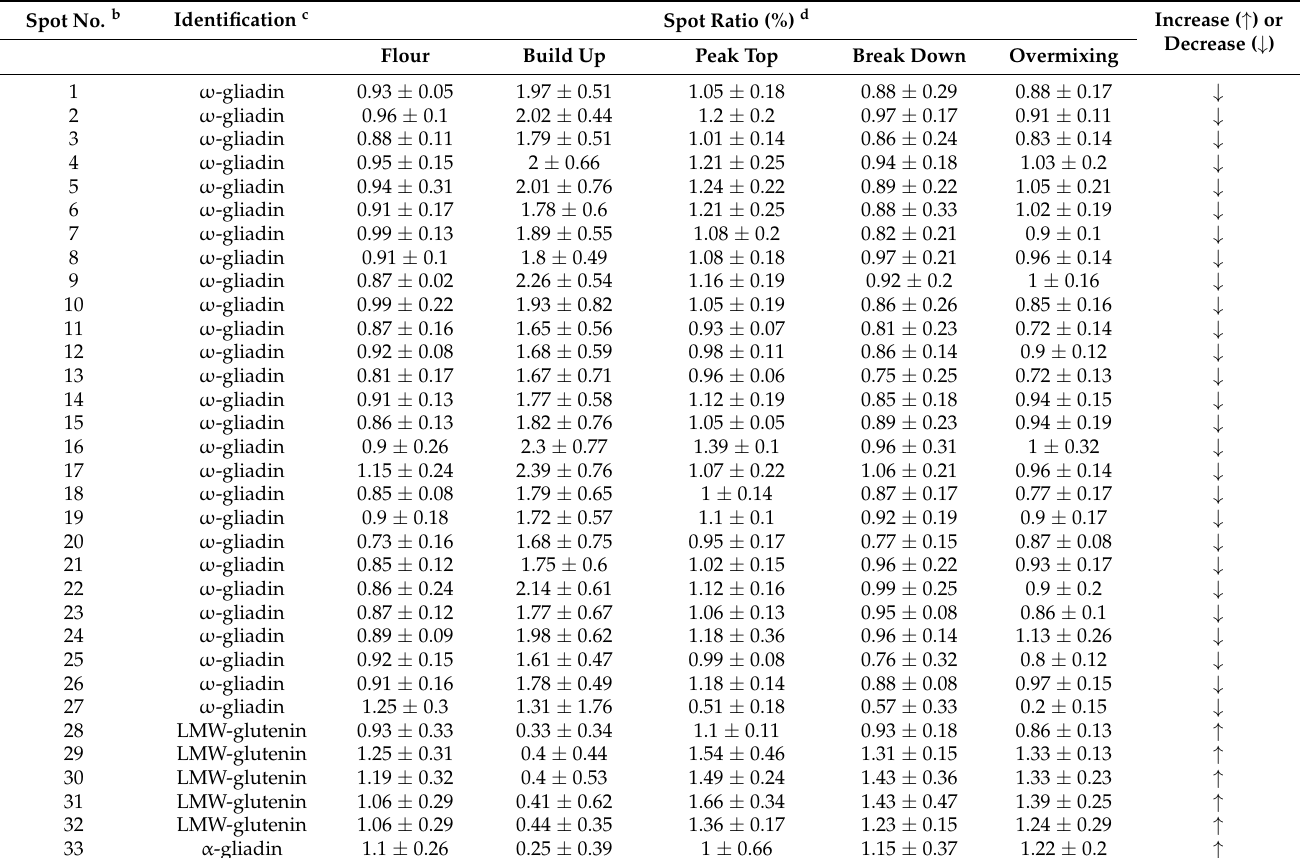
Table 2. The increased or decreased protein in monomeric protein extracted with 30% 1-propanol in HF a during mixing. Spot No.